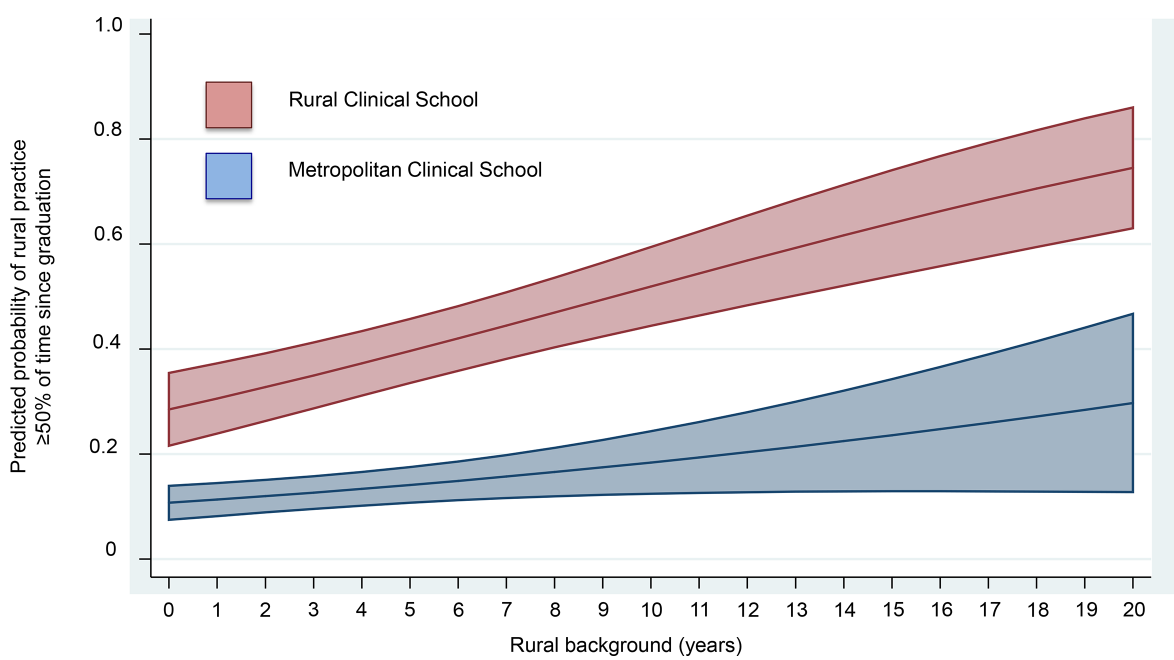
Fig 2. Adjusted predications of rural practice by yearsof rural background and Clinical School attended. The logistic regression model includedRCS versus MCS, years resided in a rural location prior to medicalschool as a continuous variable,and an interaction betweenthese two variables. Rural background—years residedin a rural area (ASGC-RA 2–5) prior to enteringmedicalschool. The shadedareas are 95% confidenceintervals.